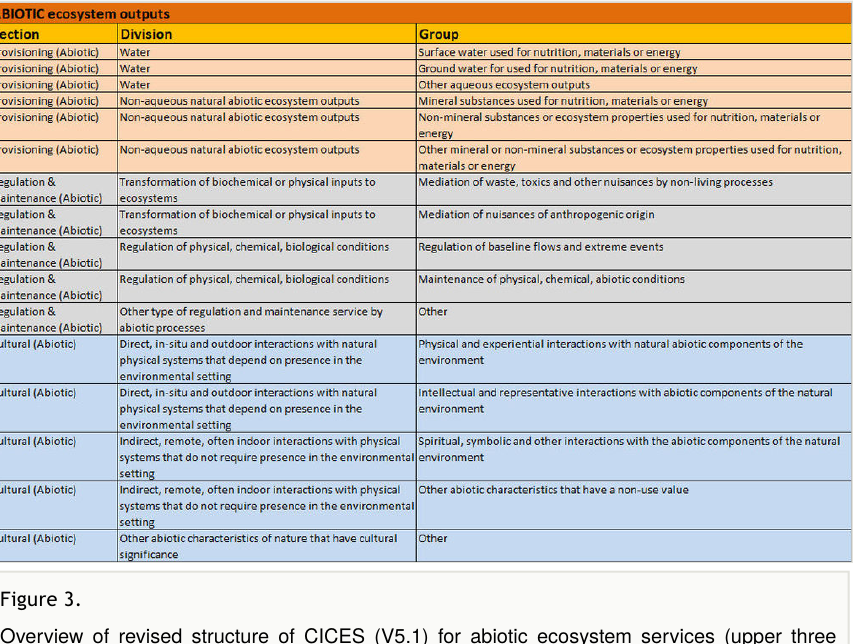
Figure 3. Overview of revised structure of CICES (V5.1) for abiotic ecosystem services (upper three levels in the classi fi cation